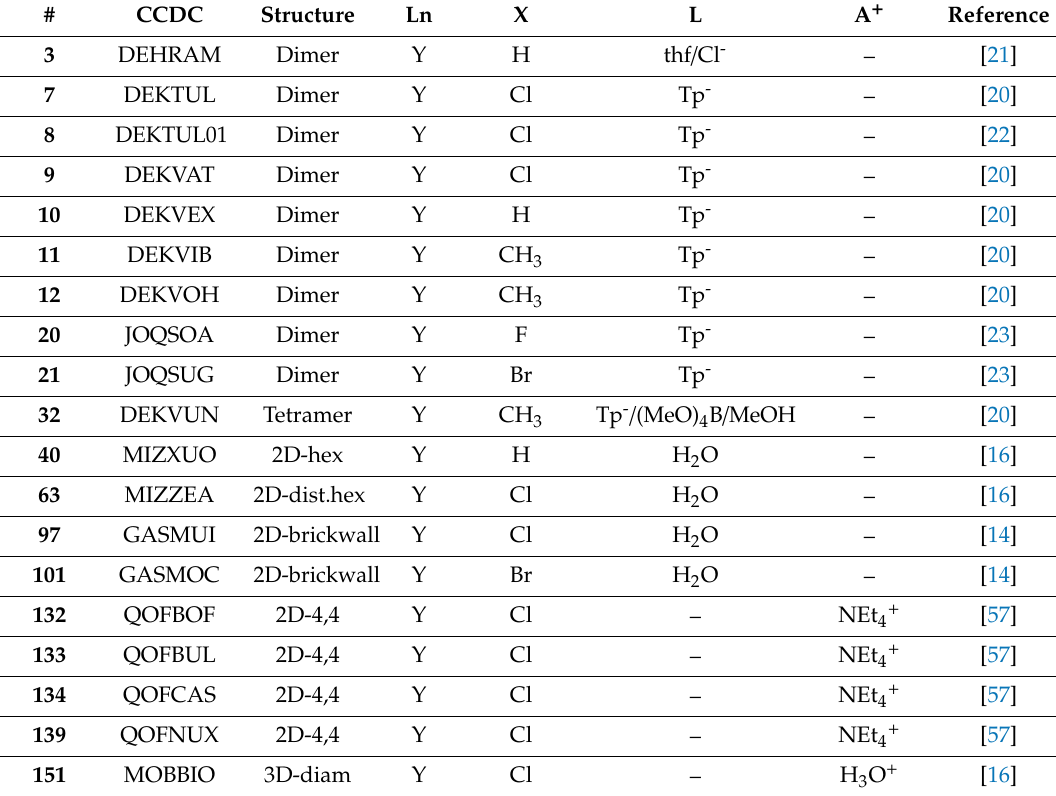
Table 13. Structurally characterized Y(III) compounds with anilato ligands.